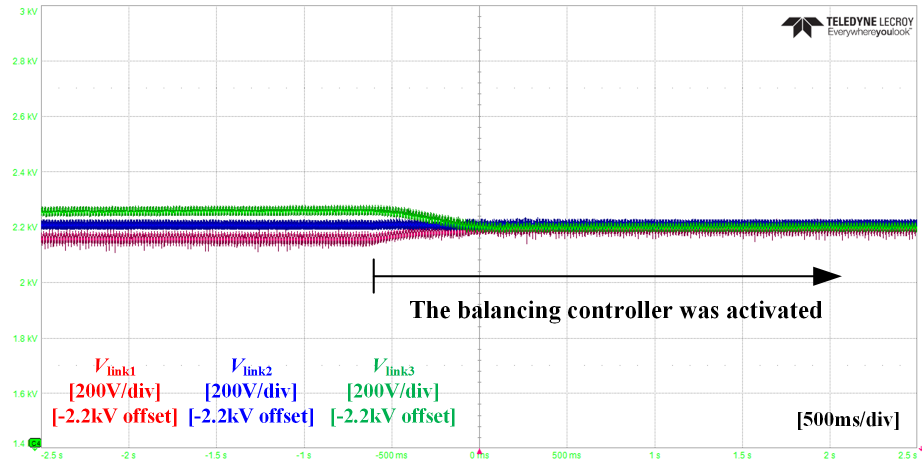
Figure 15. DC-link voltage waveform when balancing controller is